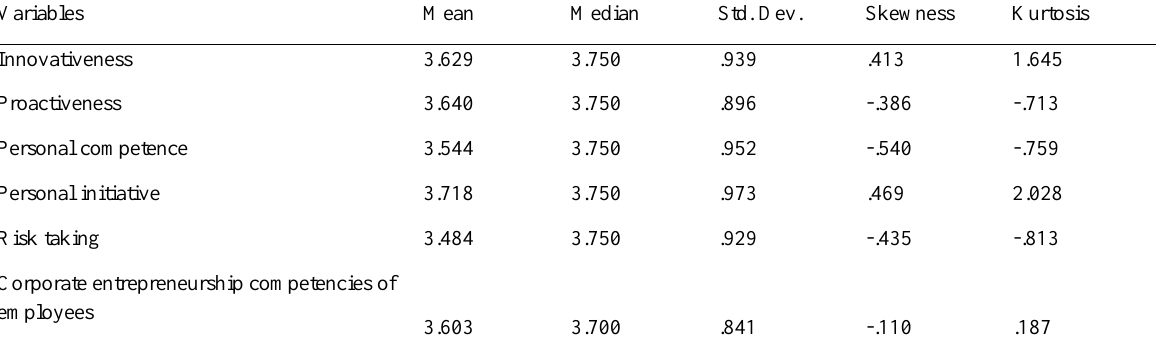
Table 2: Respondents’ Views on the Various Corporate Entrepreneurship Competencies of Employees of SMEs Variables